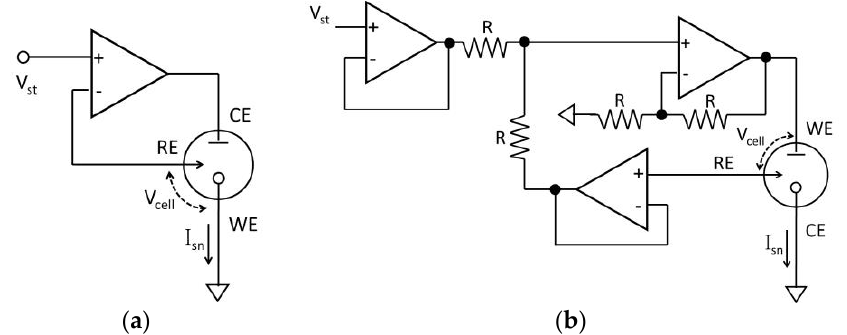
Figure 5. Three-electrode potentiostats with the ( a ) grounded-WE structure and ( b ) grounded-CE structure.